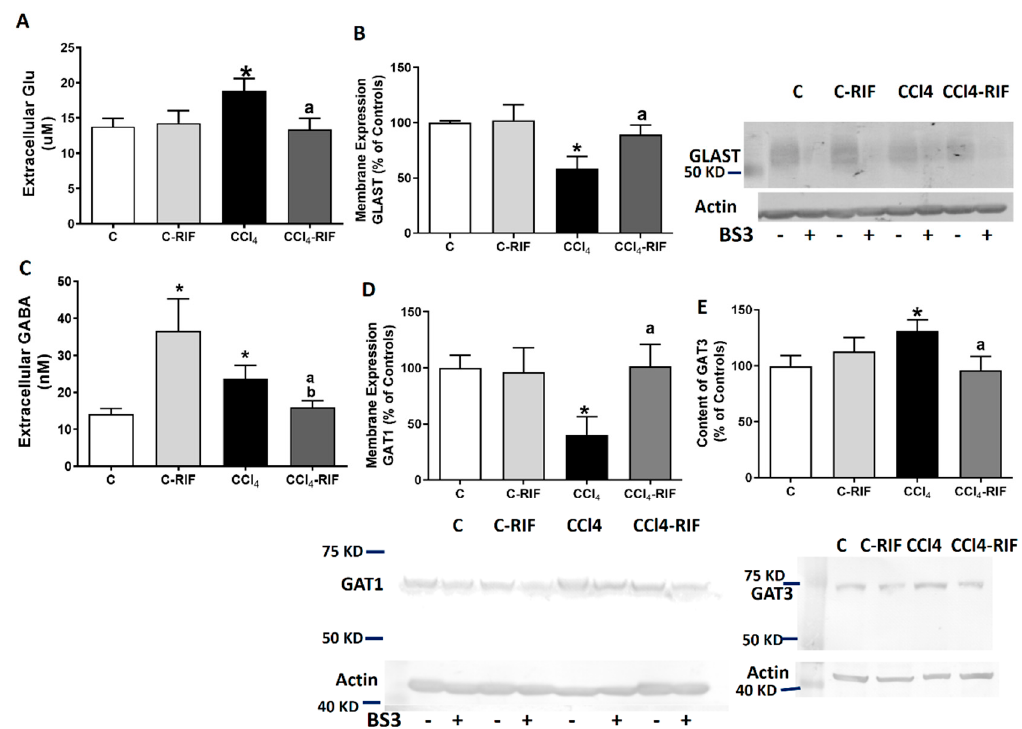
Figure 11 . Analysis of extracellular levels of GABA and Glutamate and membrane expression of their transporters. Extra- cellular levels of ( A , C ) GABA and glutamate were analyzed by microdialysis at 4 weeks. Membrane expression of ( B ) glutamate transporter GLAST and ( D , E ) GABA transporters GAT1 and GAT3 were analyzed using BS3 cross-linker. Val- ues are expressed as percentage of control rats and are mean ± SEM of 12 rats per group. One-way ANOVA with Tukey’s test for GAT-1 (F(3,27) = 4.41, p < 0.05), GAT-3 (F(3,41) = 3.27, p < 0.05) and glutamate (F(3,36) = 3.00, p < 0.05) and Welch’s ANOVA with Dunnett’s test for GABA (W(3,19) = 3.67, p < 0.05) and GLAST (W(3,13) = 12.07, p < 0.001) were performed to compare all groups. Values significantly different from control rats are indicated by asterisks, from CCl 4 rats by a, and from C-RIF rats by b. * p < 0.05, a p < 0.05, b p < 0.05.